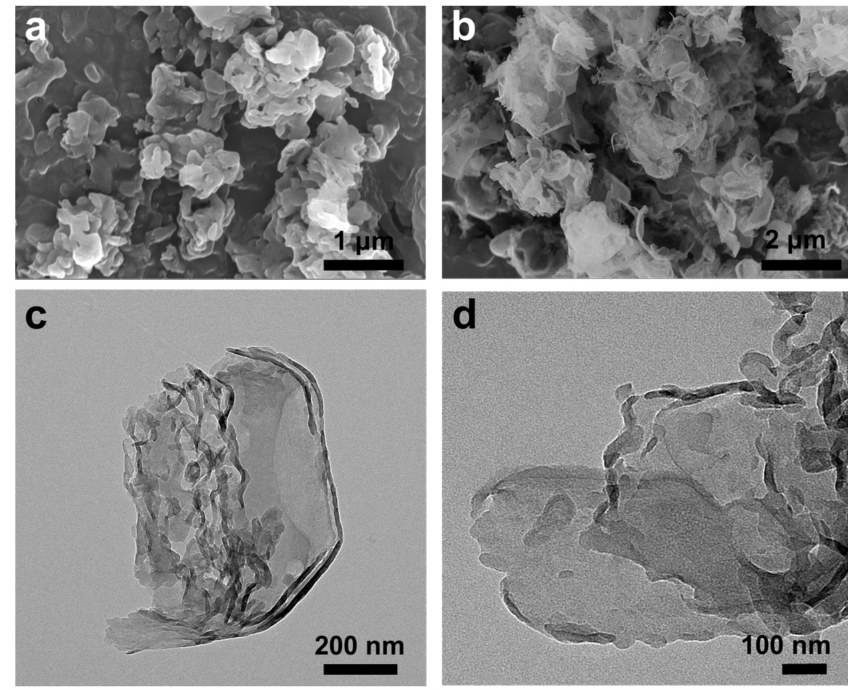
Figure 5. SEM images of ( a ) CN-H and ( b ) CNP10-H; ( c , d ) TEM images of